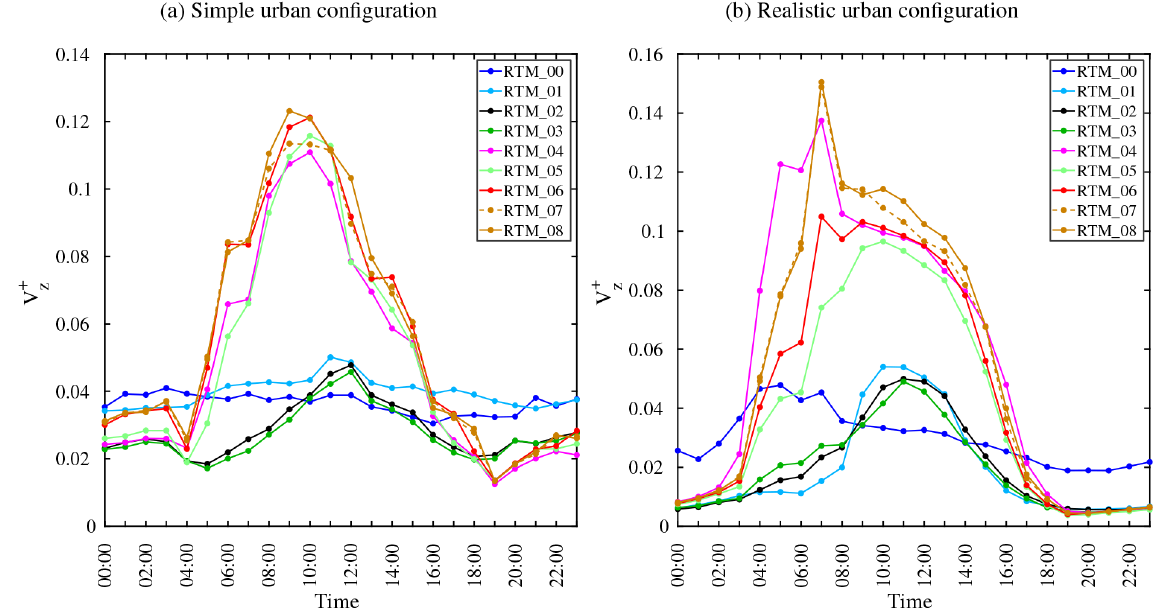
Figure 25. The normalized volumetric flow rate for (a) the realistic and (b) the simple urban configuration for all SPM